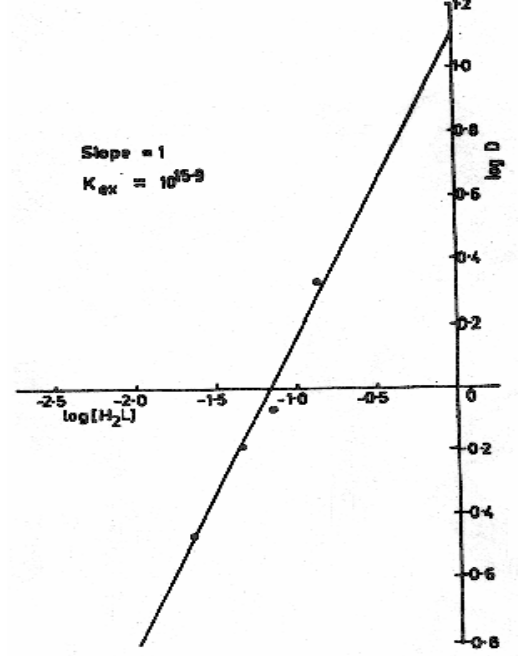
; (c) 0.001M H SO ; (d) 0.001M HClO 3 2 4